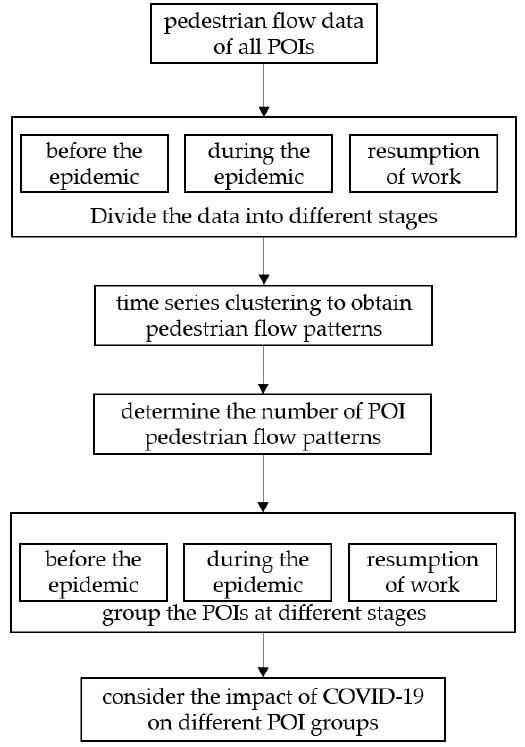
Figure 1. The framework of the study.